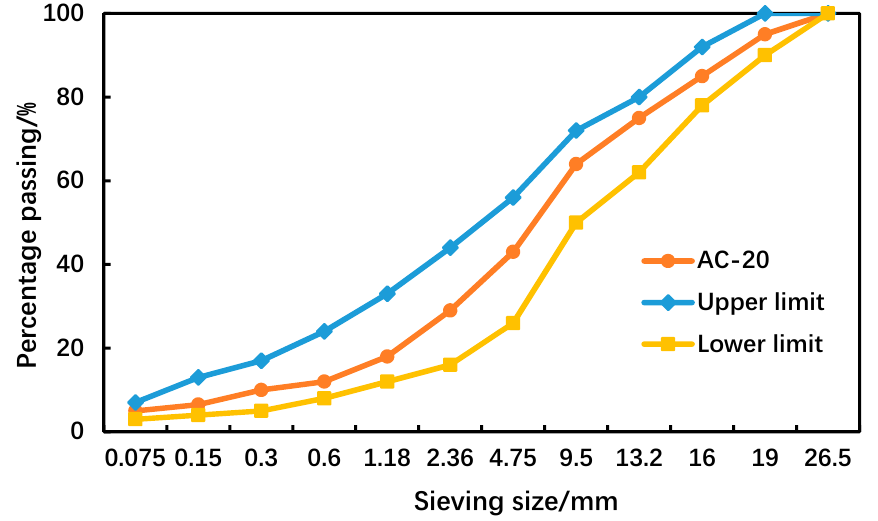
Figure 1. Gradation of the AC-20 asphalt mixture. Table 1. Volumetric properties of the AC-20 asphalt mixture.